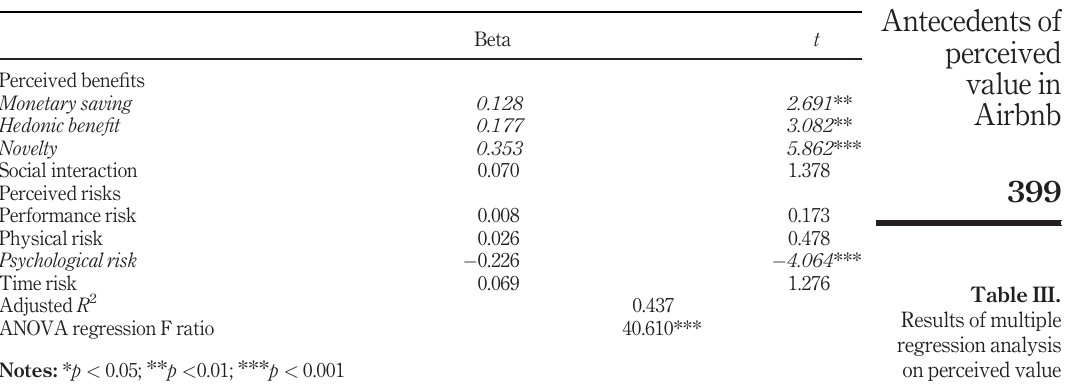
Table III. Results of